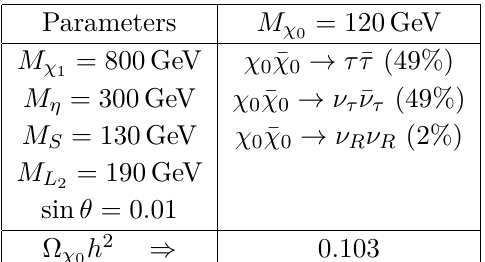
Table 7 . Dominant ( ≥ 1% ) annihilation channels relevant in determining the relic density at = 120 GeV. M χ 0